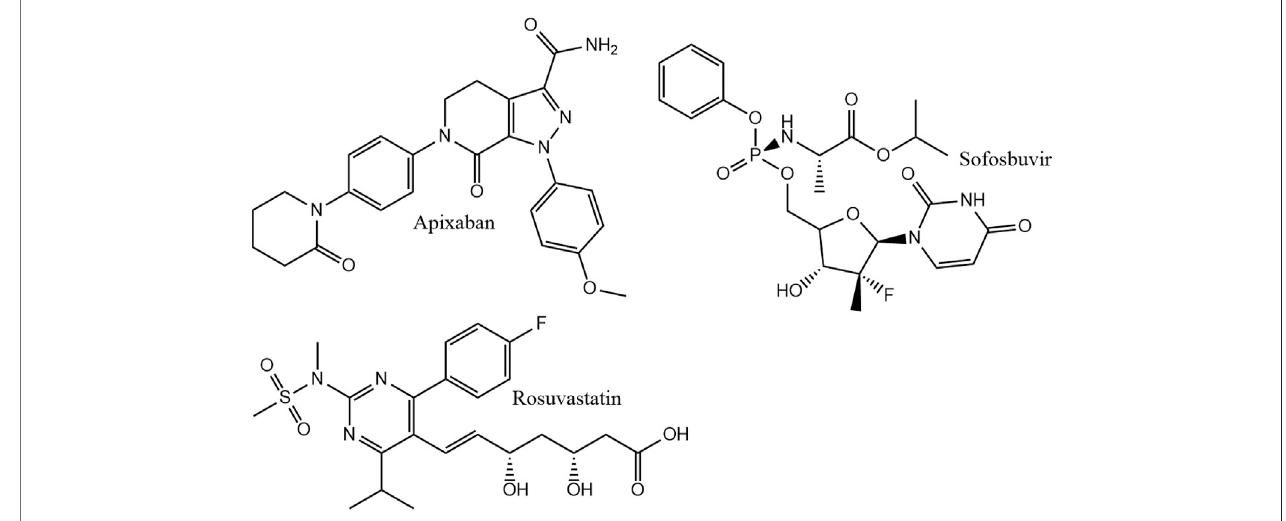
FIGURE 1 | Seed molecules for dataset generation.